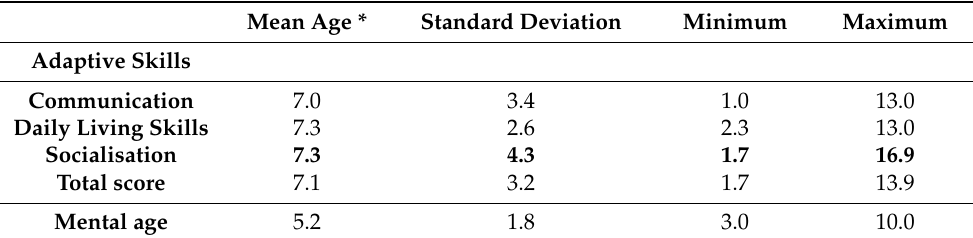
Table 1. Mean equivalent ages of adaptive behaviour in DS individuals on main domains, total score and mean mental age (in years). Mean Age * Standard Deviation Minimum Maximum Adaptive Skills